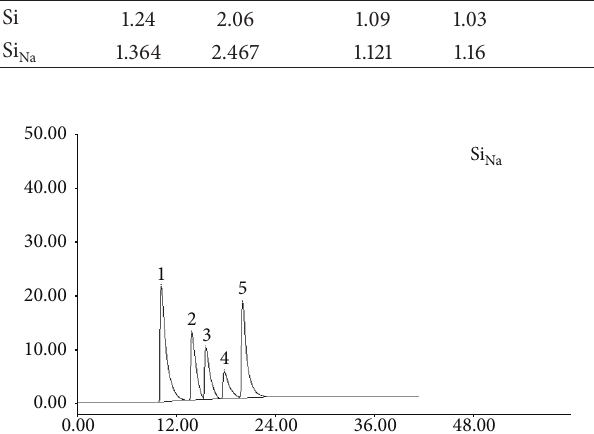
Table 6: Separation efficiency parameters of selected stationary phases using polyaromatics as probes. Naphthalene, fluorine Column